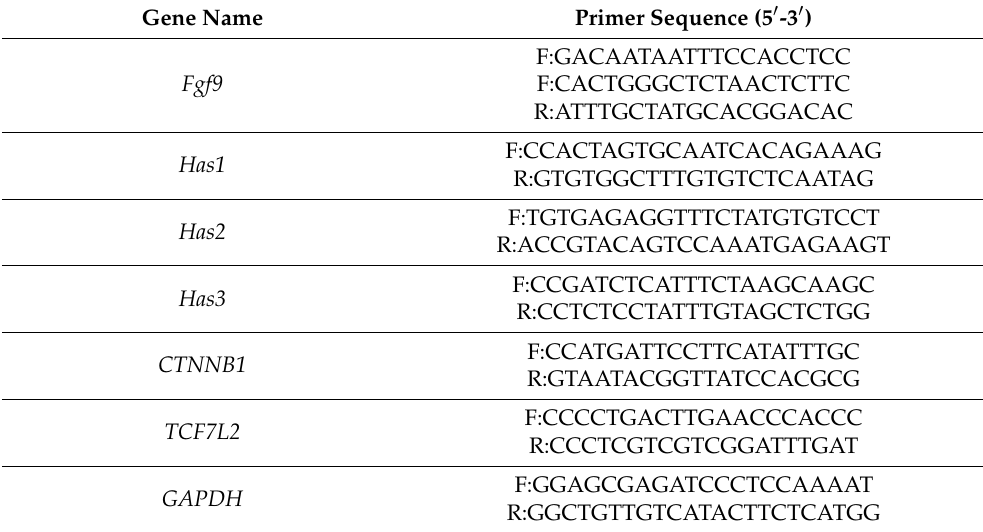
Table 1. Primers of studied